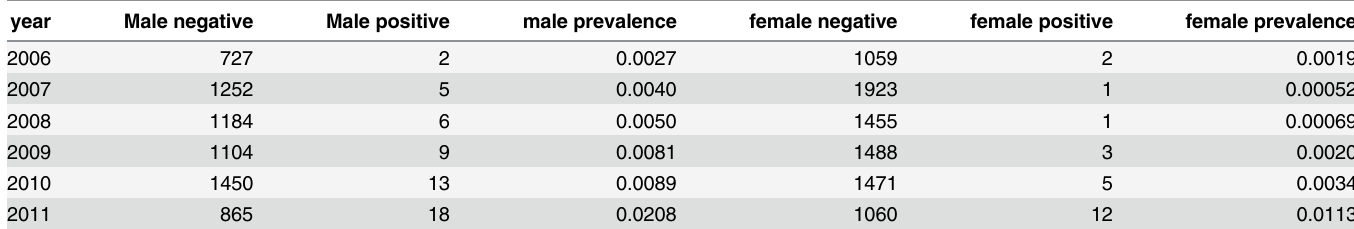
Table 1. Hunter harvest and CWD prevalence estimates for 2006 – 2011. Male negative